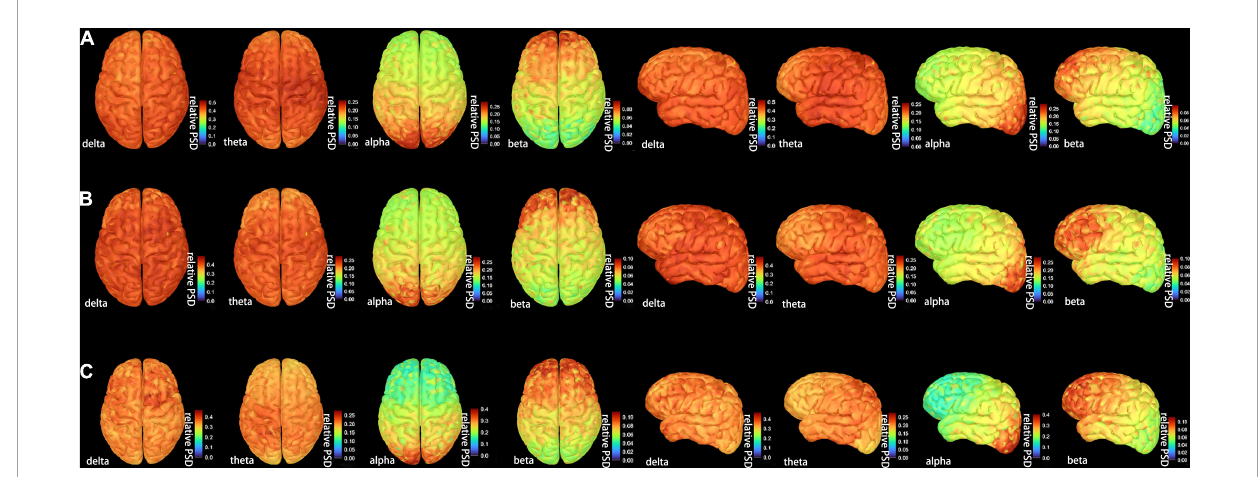
FIGURE2 The distribution of the whole-brain average cortical activation in resting-state condition in (A) the cognitive impairment (CI) group, (B) the cognitive nonimpairment (CNI) group, and (C) healthy controls. We showed only four frequency bands with the most significant differences. The activation maps were shown in two views: top and dorsal; the current power of the underlying cortical sources were color-coded, as the values increased, the color gradually changed from blue to red. PSD = relative power spectral density. The complete distribution of the whole-brain average cortical activation are shown in Supplementary Figure 1